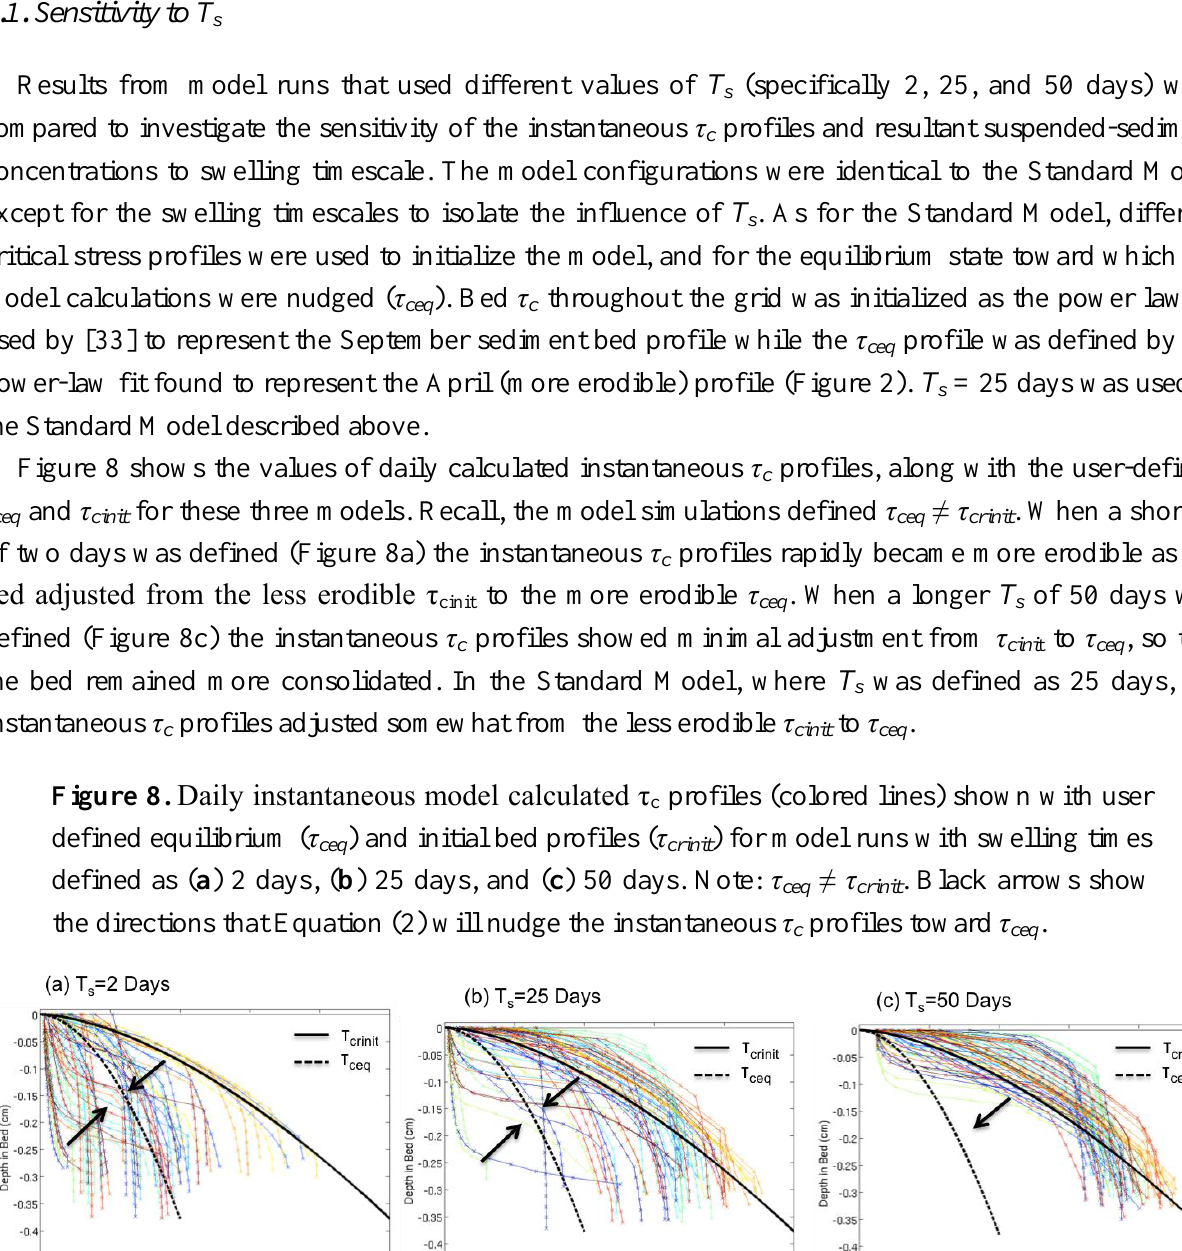
) and initial bed profiles ( τ ceq